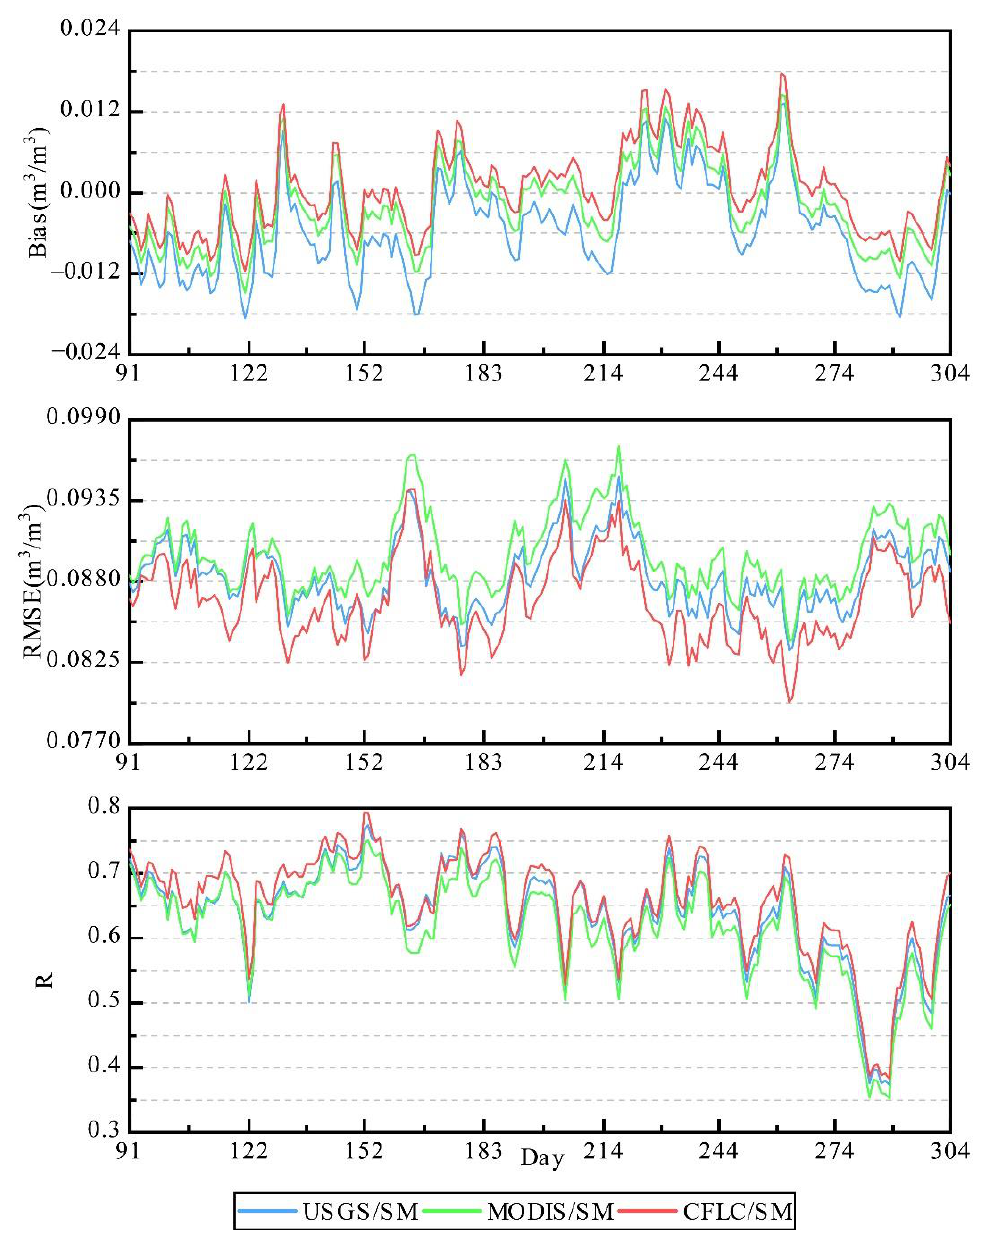
Figure 7. Daily scale analysis of 0 – 10 cm soil moisture between simulation result and observation. The significance level of all the data is p < 0.01.